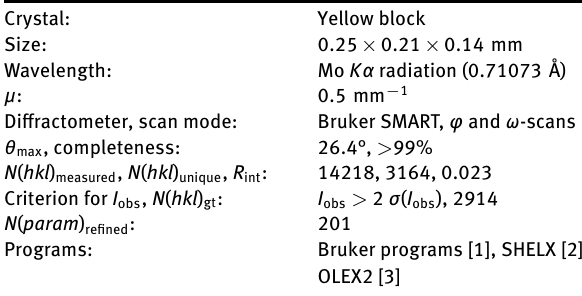
Table 2: Fractional atomic coordinates and isotropic or